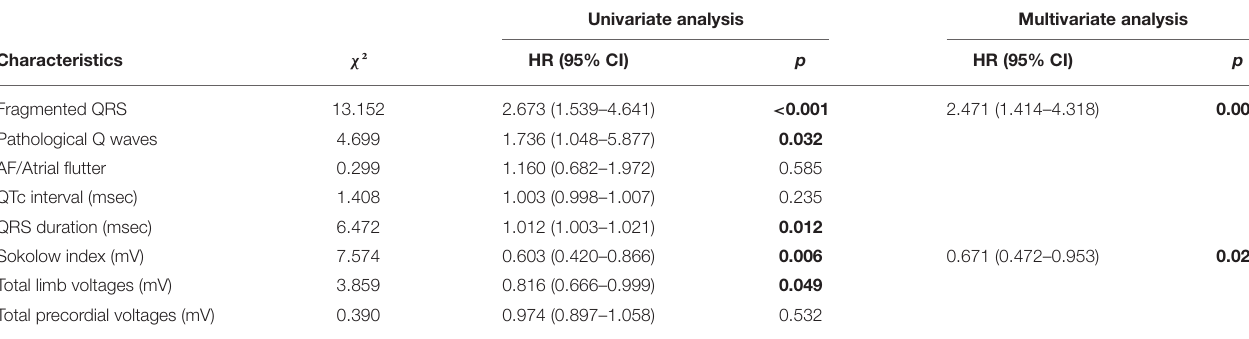
TABLE 3 | Univariate and multivariate cox proportional hazard regression analysis using ECG values to identify electrocardiographic predictors of all-cause mortality. Univariate analysis Multivariate